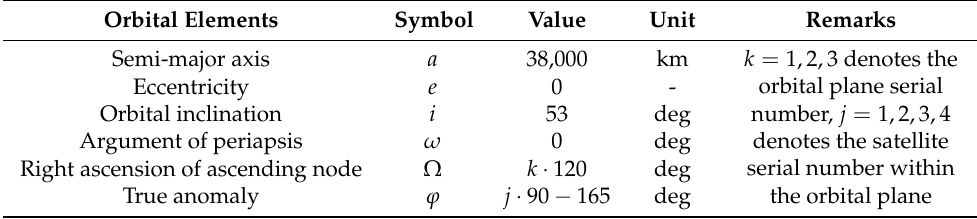
Table 1. The orbital elements of our interceptor satellites.